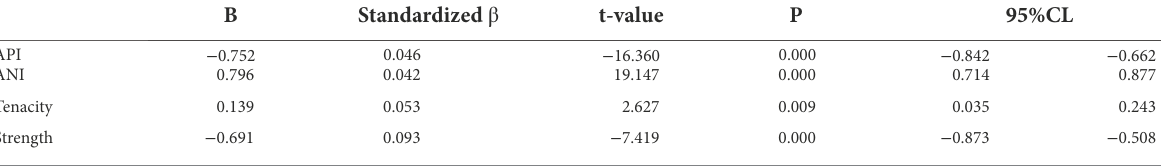
TABLE 6 Multiple linear regression analysis between attentional bias, resilience, and depressive symptoms in the research